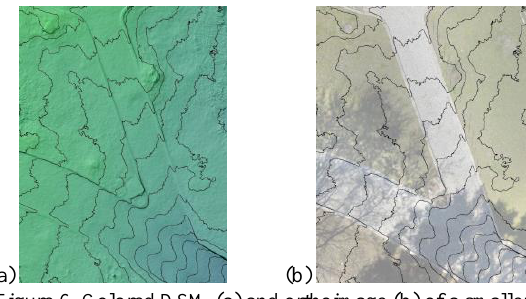
Figure 6. Colored DSM (a) and orthoimage (b) of a smaller area, with 10 cm vertical spacing contours.